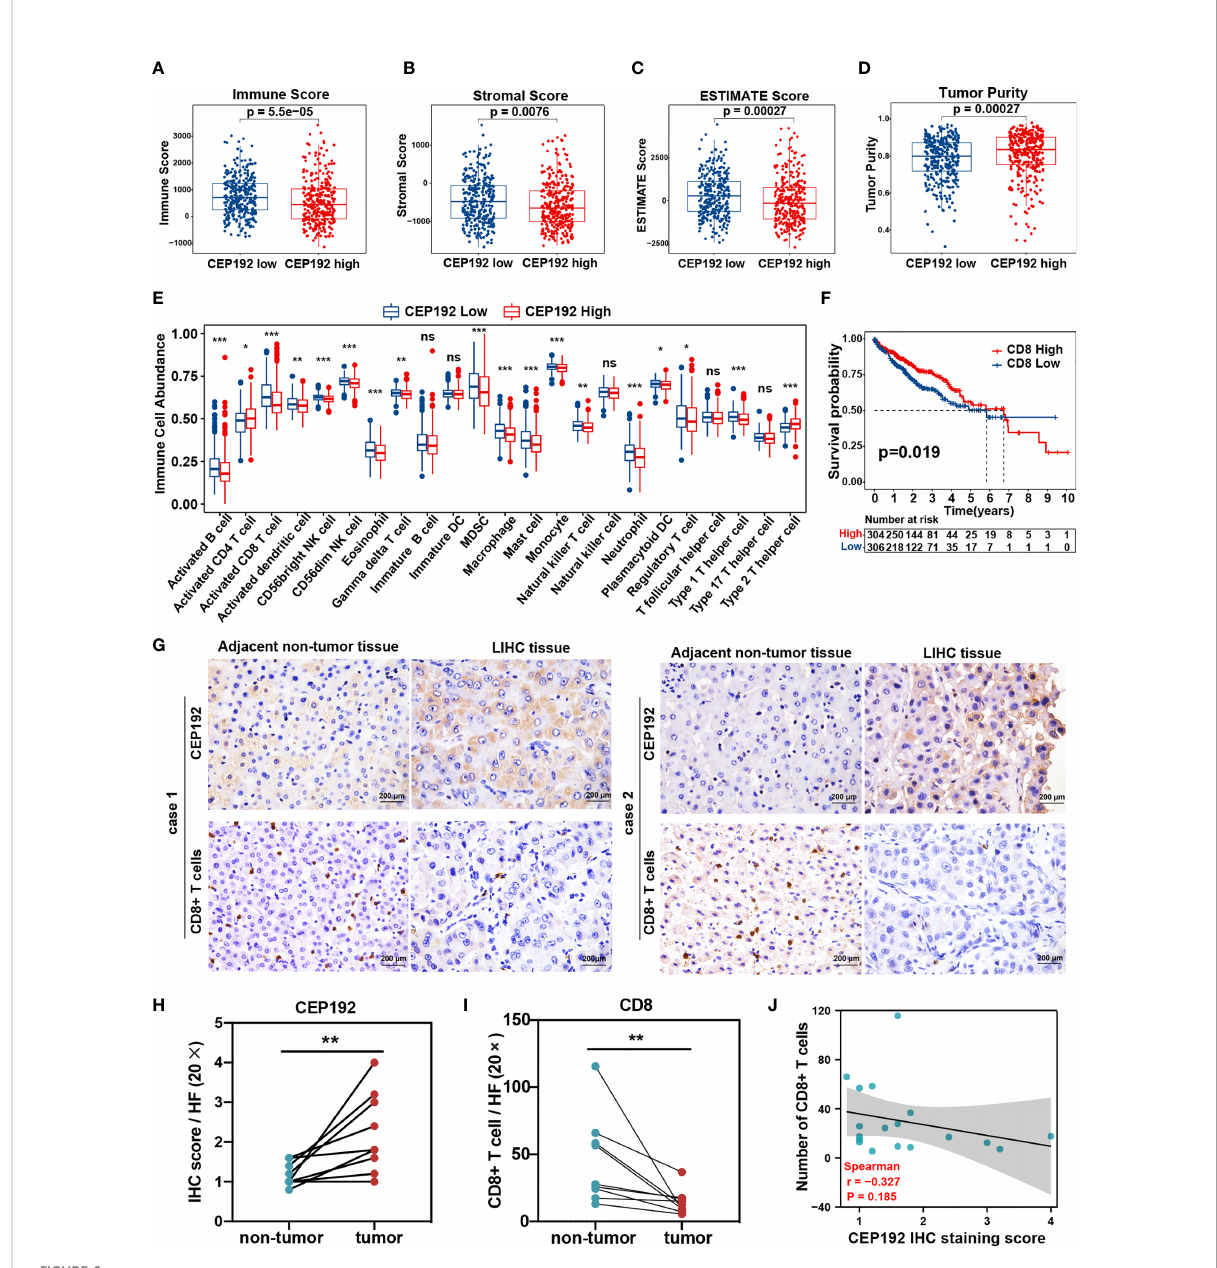
FIGURE 6 Correlation analysis of CEP192 expression and immune cell in fi ltration in HCC. (A – D) Immune Score (A) , Stromal Score (B) , ESTIMATE Score (C) , and Tumor Purity (D) between the CEP192 low ( n = 306) and CEP192 high ( n = 305) group based on HCC patients from TCGA-LIHC ( n = 371) and ICGC-LIRI-JP ( n = 240) datasets. Mean ± SEM, Mann – Whitney U test. (E) Distribution of 23 types of immune cells in the CEP192 low ( n = 306) and high ( n = 305) groups based on ssGSEA. Mean ± SEM, Mann – Whitney U test, * p <0.05, ** p <0.01, *** p <0.001. (F) Kaplan – Meier curve described the signi fi cant survival difference between CD8 high ( n = 306) and low groups ( n = 304). Log-rank (Mantel-Cox) test. (G) Immunohistochemical staining showing the level of in fi ltrating CD8+ T cells and CEP192 expression in HCC tumor tissues ( n = 9) compared with adjacent non-tumor liver tissues ( n = 9). Scale bar: 200 m m. (H) The CEP192 expression levels in (G) were quanti fi ed with an IHC score using ImageJ ( n = 9); mean ± SEM, paired t -test, ** p <0.01. (I) The number of in fi ltrating CD8+ T cells in (G) was counted by a pathologist ( n = 9); mean ± SEM, paired t -test, ** p <0.01. (J) Correlation analysis of CEP192 expression and CD8+ T-cell in fi ltration in (G) ; Spearman ’ s rank correlation rho. NS, non signi fi